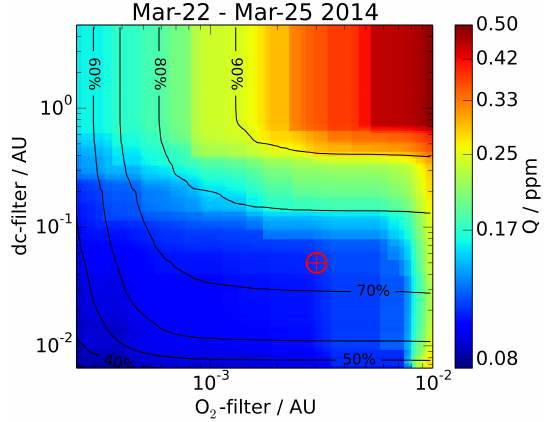
Figure 3. Effect of filter threshold for the O 2 filter (abscissa) and the DC filter (ordinate) on the standard deviation of retrieved XCO 2 (color coded in logarithmic scale). Standard deviation of XCO 2 is calculated for 4 sample days after subtracting a 3rd order polyno- mial that accounts for diurnal and day-to-day variability. The data yield is overlayed as solid black contours. The finally chosen fil- ter thresholds (5% for the DC filter and 0.3% for the O 2 filter) are marked with the red